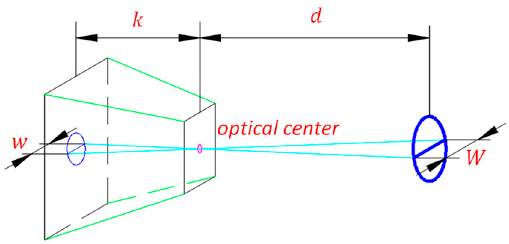
Figure 13. Camera model.